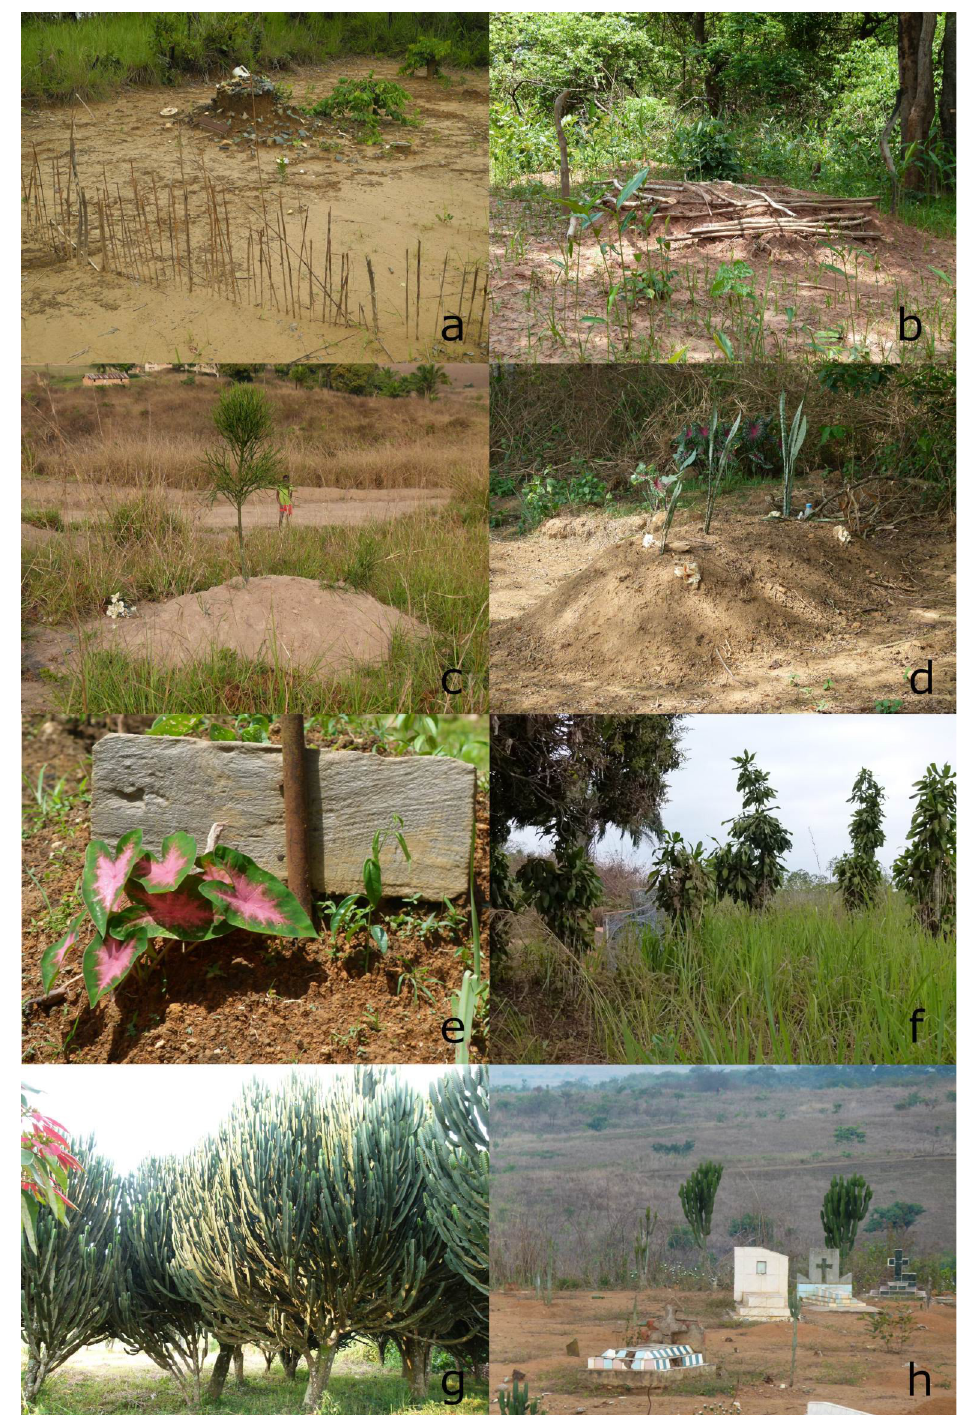
Fig 3. Plants on graveyards in Uı´ge province. (a) Traditional BaKongo graveyard with old ceramic, (b) Erythrophleum africanum used for mark graveyards in the municipality of Kangola, (c) Euphorbia tirucalli , (d) Sansevieria sp., (e) Caladium bicolor , (f) Dracaena fragrans , (g) Euphorbia cf. ingens trees, (h) hudge Euphoria trees at a cemetery in the municipality of